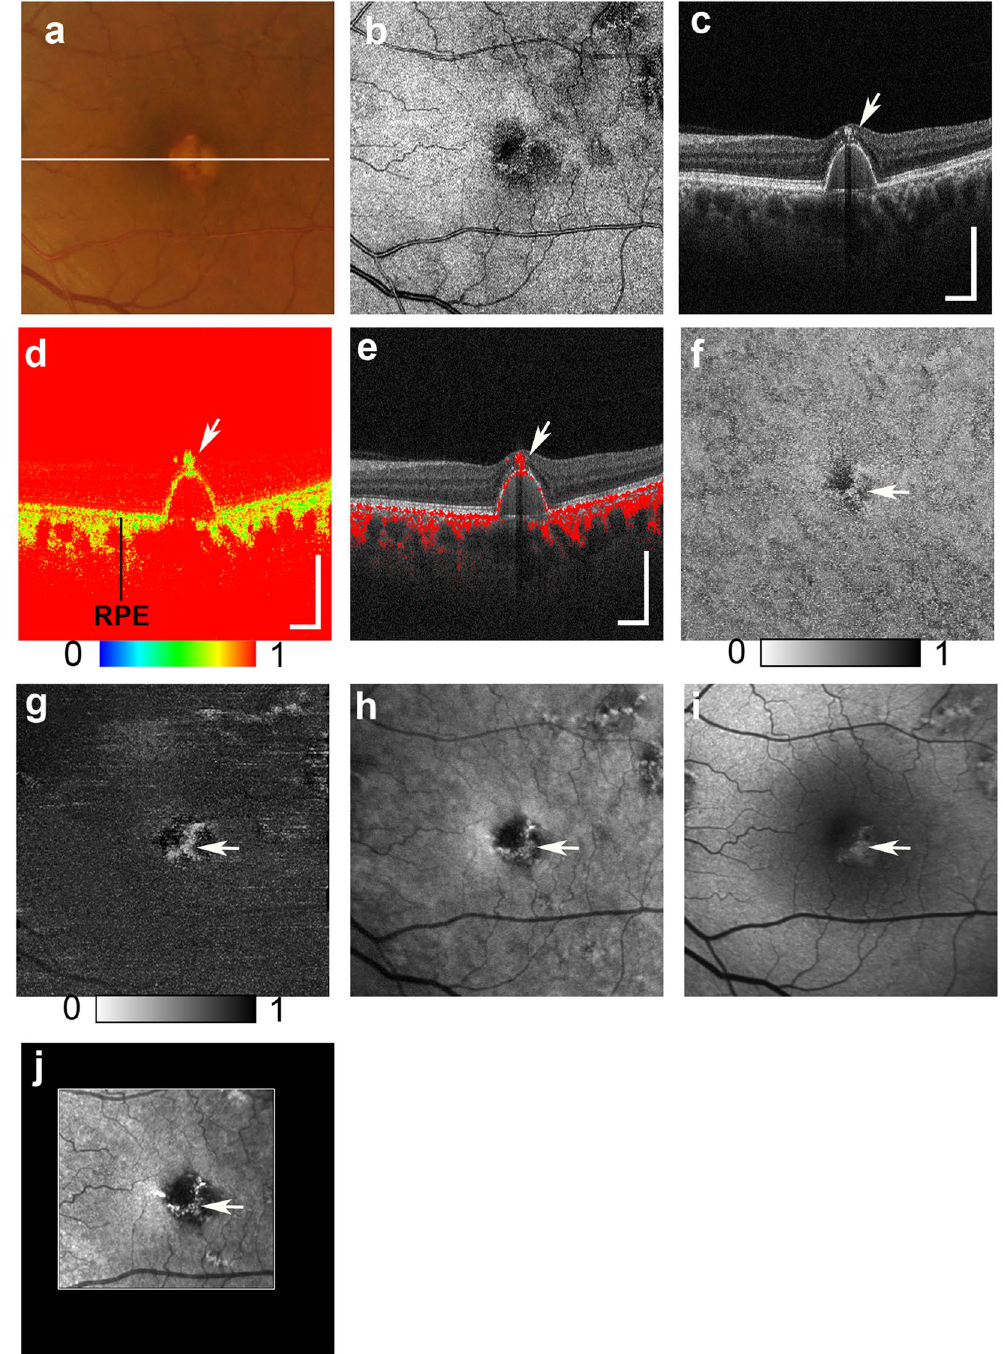
Figure 2. Multimodal imaging of drusenoid pigment epithelial detachment (PED) from the left eye of a 65-year-old male. The white line in the color fundus photograph ( a ) indicates the scan line of the PS-OCT B-scan images ( c,d,e ). An en face projection of the standard OCT image ( b ). The standard OCT B-scan image ( c ) showing HRF (white arrow). A pseudocolor image of the corresponding DOPU B-scan image ( d ) and composite DOPU B-scan OCT images (e) showing depolarization at the HRF (white arrows). The scale bars represent 500 μ m × 500 μ m. An en face projection image of the minimum DOPU along the whole depth ( f ) and an en face projection of the minimum DOPU anterior to the retinal pigment epithelium ( g ), which showed depolarization at corresponding locations of HRF (white arrows). The corresponding NIR-AF image ( h ) and SW-AF image ( i ) show hyper-AF at corresponding locations of HRF (white arrows). A depolarized light image using the PS-SLO ( j ) shows depolarization at corresponding locations of HRF (white arrow). All abbreviations used are as defined in the figure legend for Fig.